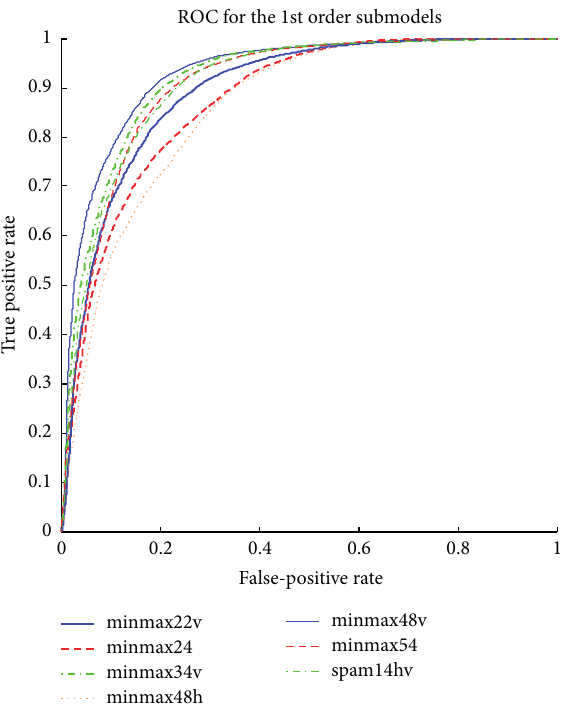
Figure 5: ROC curves for third order features.